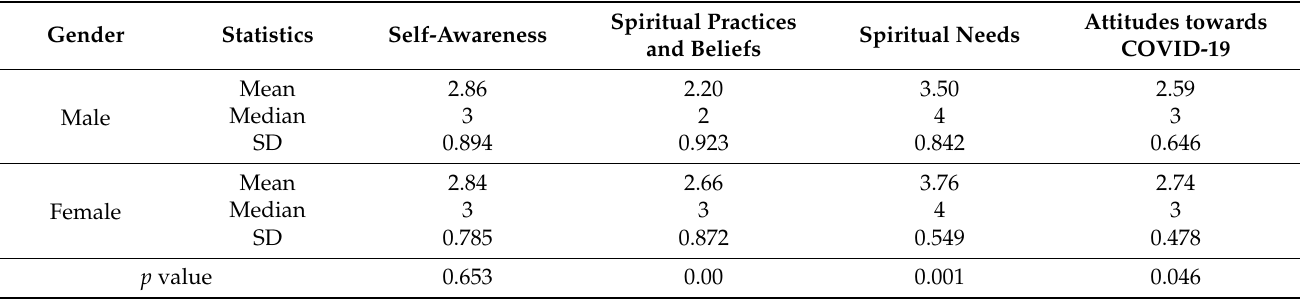
Table 5. Mean, median, and standard deviation (SD) by dimension according to students’ gender.